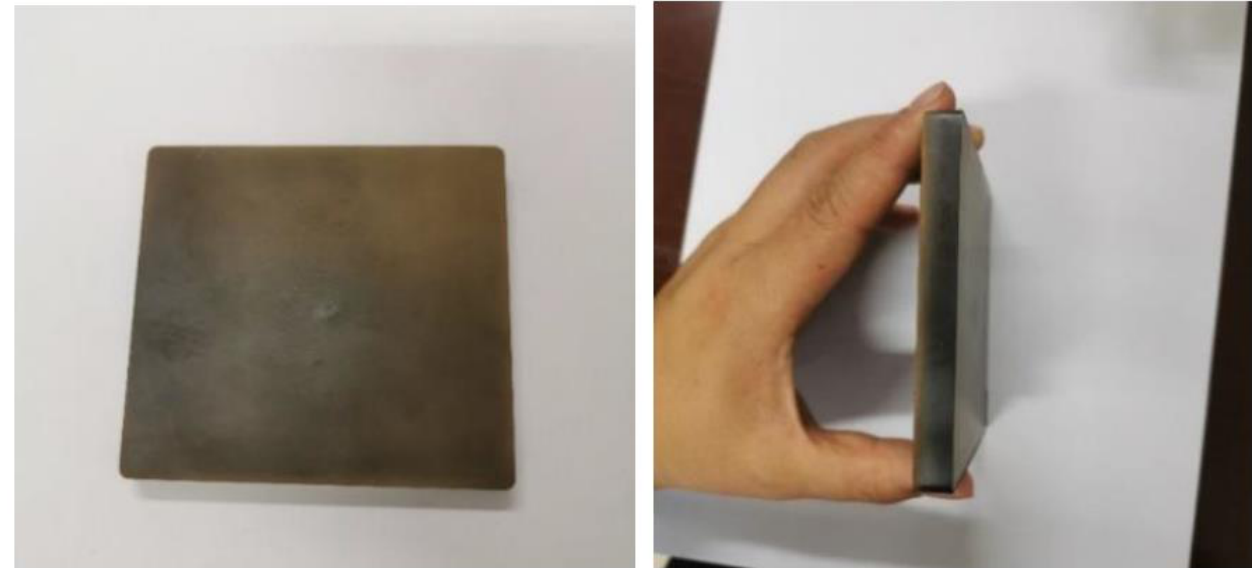
Figure 4. The B 4 C/TiO 2 /polyimide molded plate.